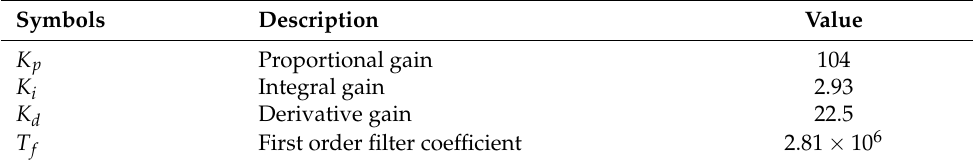
Table 4. Parameter optimization results of fixed-structure H ∞ synthesis.